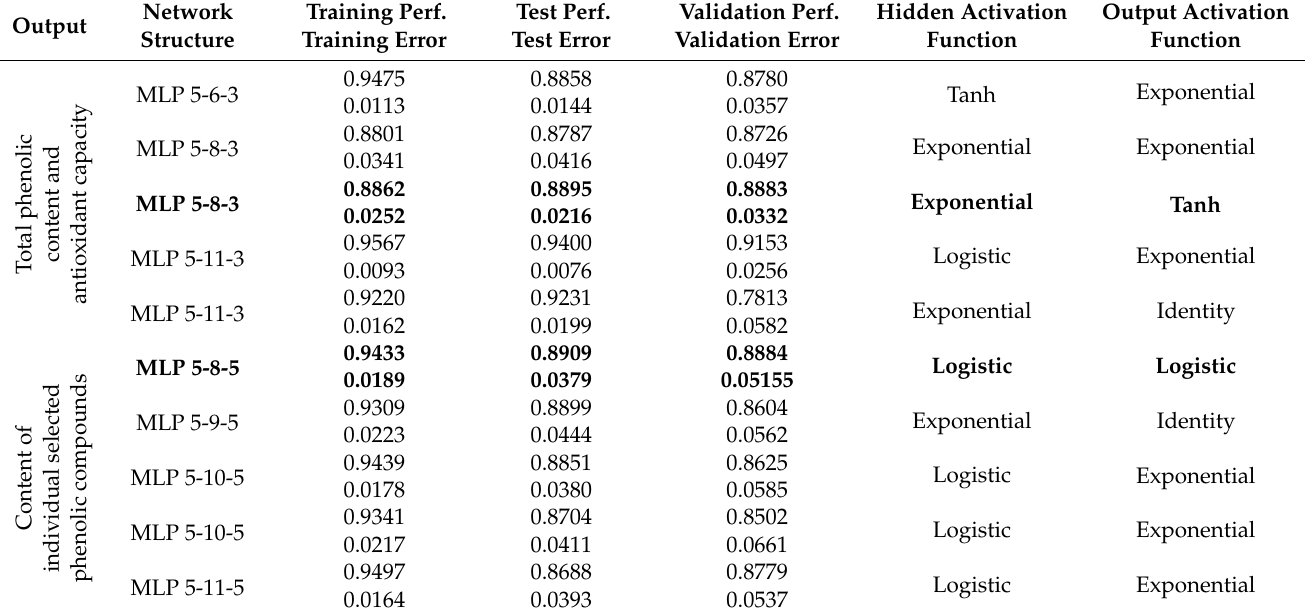
Table 4. Architecture of ANNs developed for prediction of (i) total phenolic content and antioxidant capacity, and (ii) content of individual selected phenolic compounds in ground ivy extracts based on NIR spectra (selected networks are marked